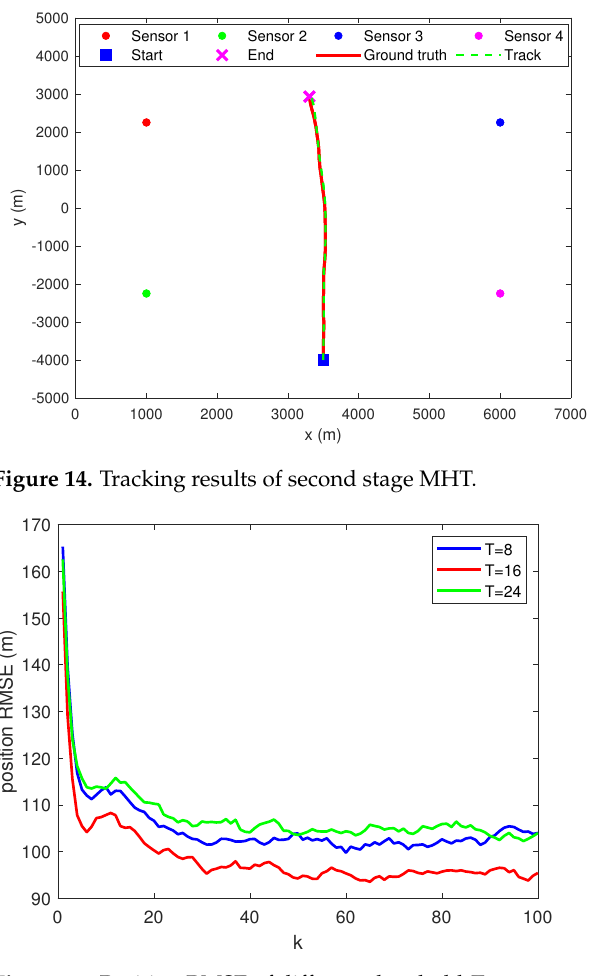
Figure 15. Position RMSE of different threshold T